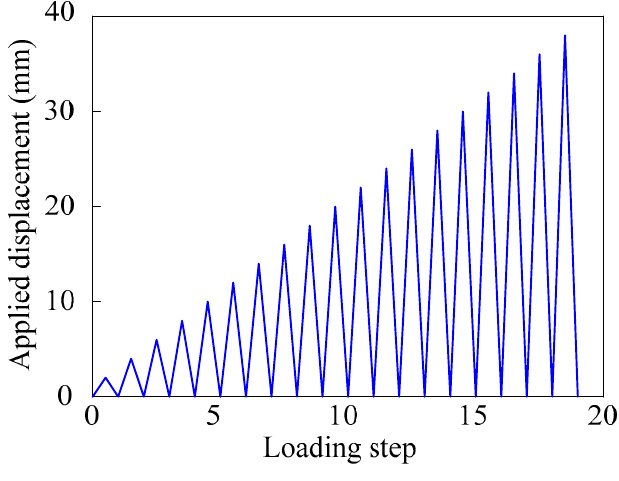
Figure 7. Loading protocol. Figure 7. Loading